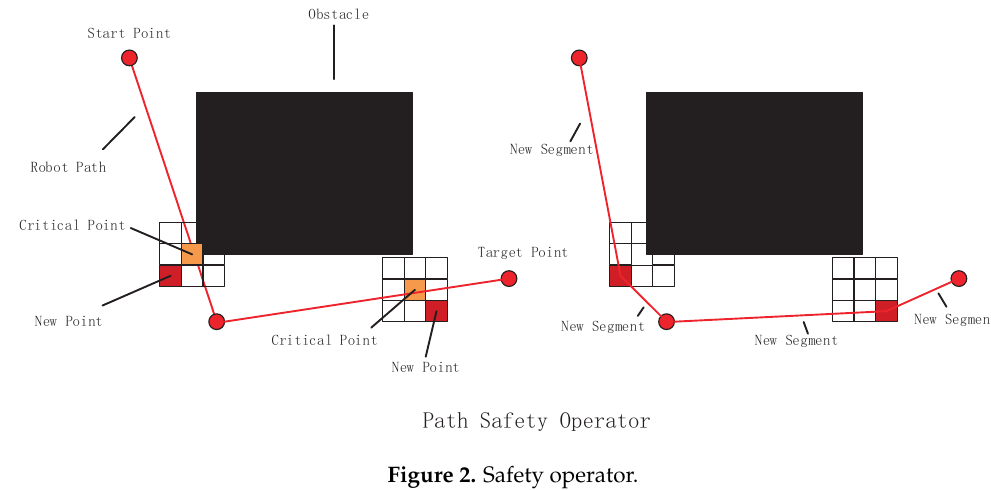
Figure 2. Safety